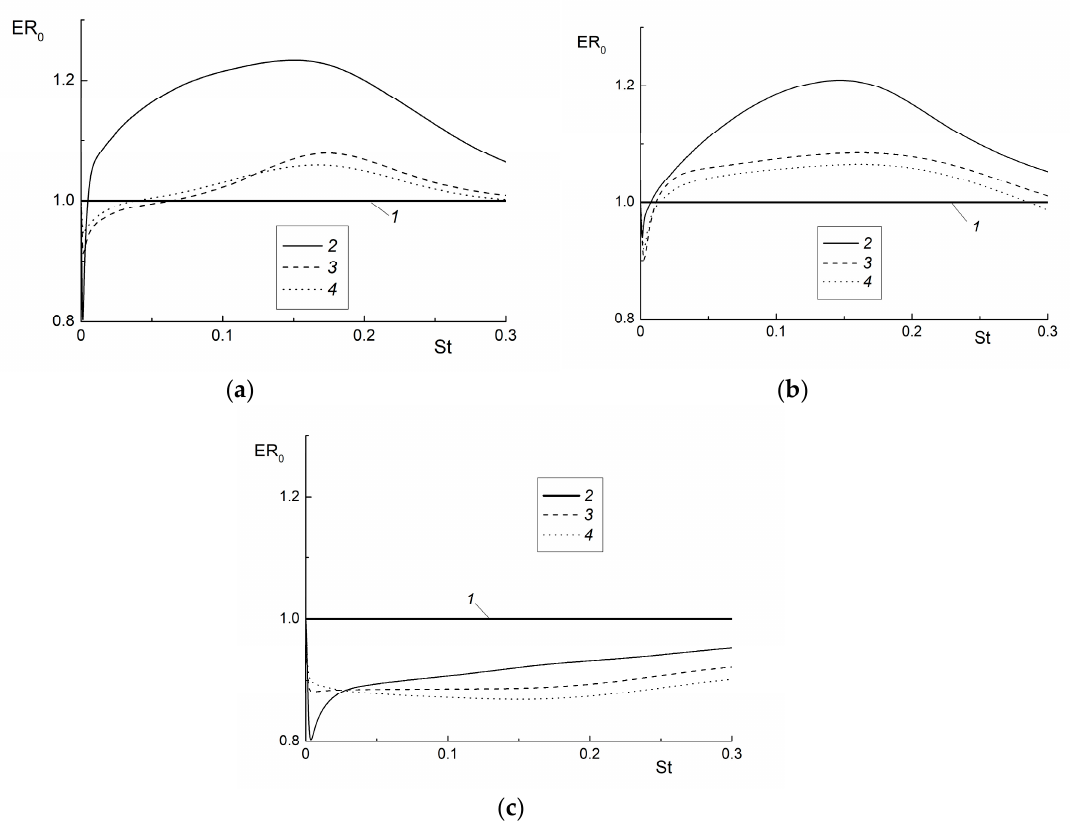
Figure 7. Heat transfer enhancement ratio at the stagnation point of an impinging pulsed jet vs. the Strouhal number at H / D = 2 ( a ), 6 ( b ) and 10 ( c ) Re = 23000. 1 —steady-state impinging jet ( f = 0 Hz), 2 —rectangular, 3 —sinusoidal, 4 —triangular.